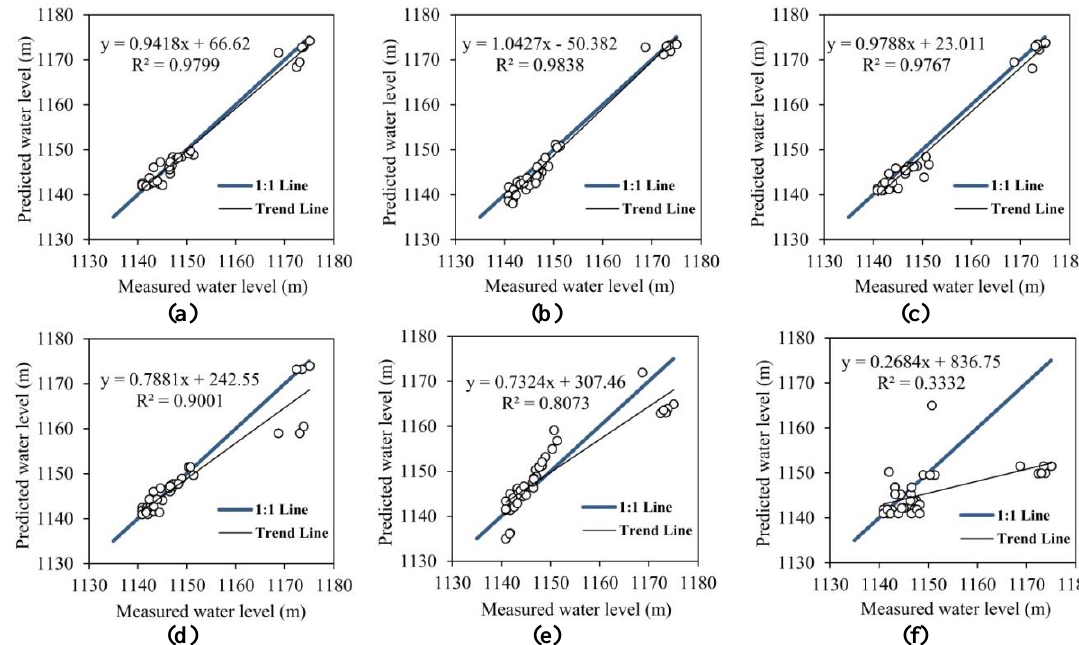
Figure 6. Results obtained from data-driven models in test stage for simulating piezometer 20 level variations; (a) ANN-PSO, (b) ANN-LM, (c) ANN-HS, (d) RDT, (e) MLR, (f) CDT